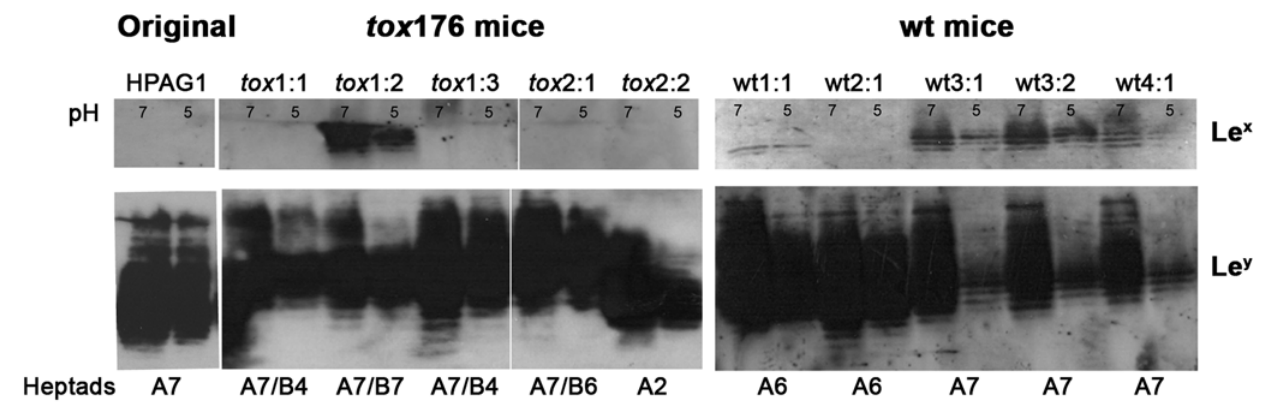
Figure 1. Lewis phenotypes of HPAG1 isolates after a one-year colonization in germ-free tox 176 and wildtype mice. H. pylori strain HPAG1 was used for a one-year colonization of germ-free tox 176 and non-transgenic (wildtype) mice with high and low gastric pH, respectively. LPS was extracted from five single-colony re-isolates from tox 176 mice (n=2) and five single-colony re-isolates from wildtype mice (n=4) grown in vitro at both pH 7 and pH 5. Immunoblot analysis with antibodies detecting Le x and Le y showed that isolates from wildtype mice had switched Lewis phenotype to simultaneous Le x and Le y expression, as compared to the inoculating HPAG1 strain and the tox 176-passaged HPAG1 isolates. Some isolates (wt3:1, wt3:2 and wt4:1) appeared to express O-antigen chains that were less fucosylated when grown in vitro at pH 5 as compared to growth at pH 7. DNA sequencing showed that; FutA was ‘‘on’’ in all isolates; FutB was ‘‘on’’ in four tox 176-passaged isolates ( tox1 :1-1:3 and tox 2:1); and the number of heptad-repeats varied in active FutA and FutB enzymes, which is indicated below the